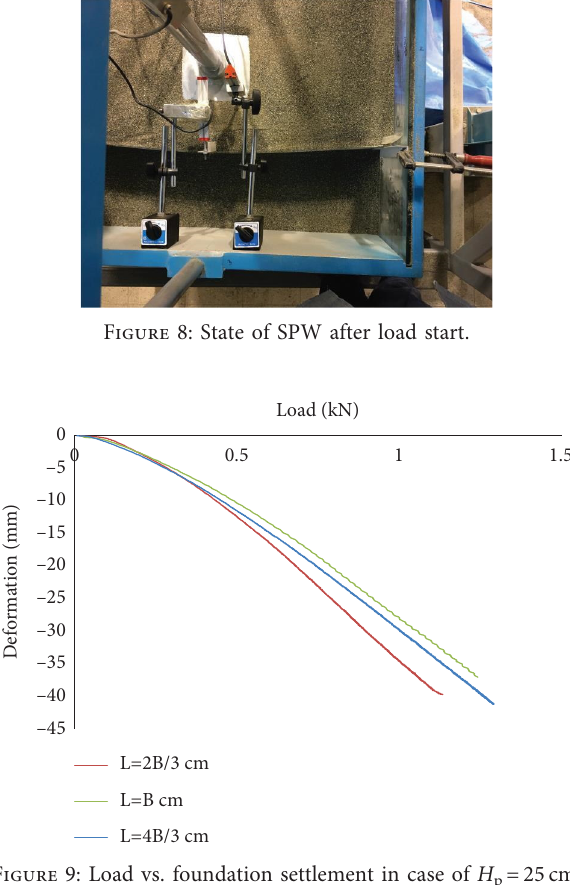
Figure 7: State of SPW before load start – 2.